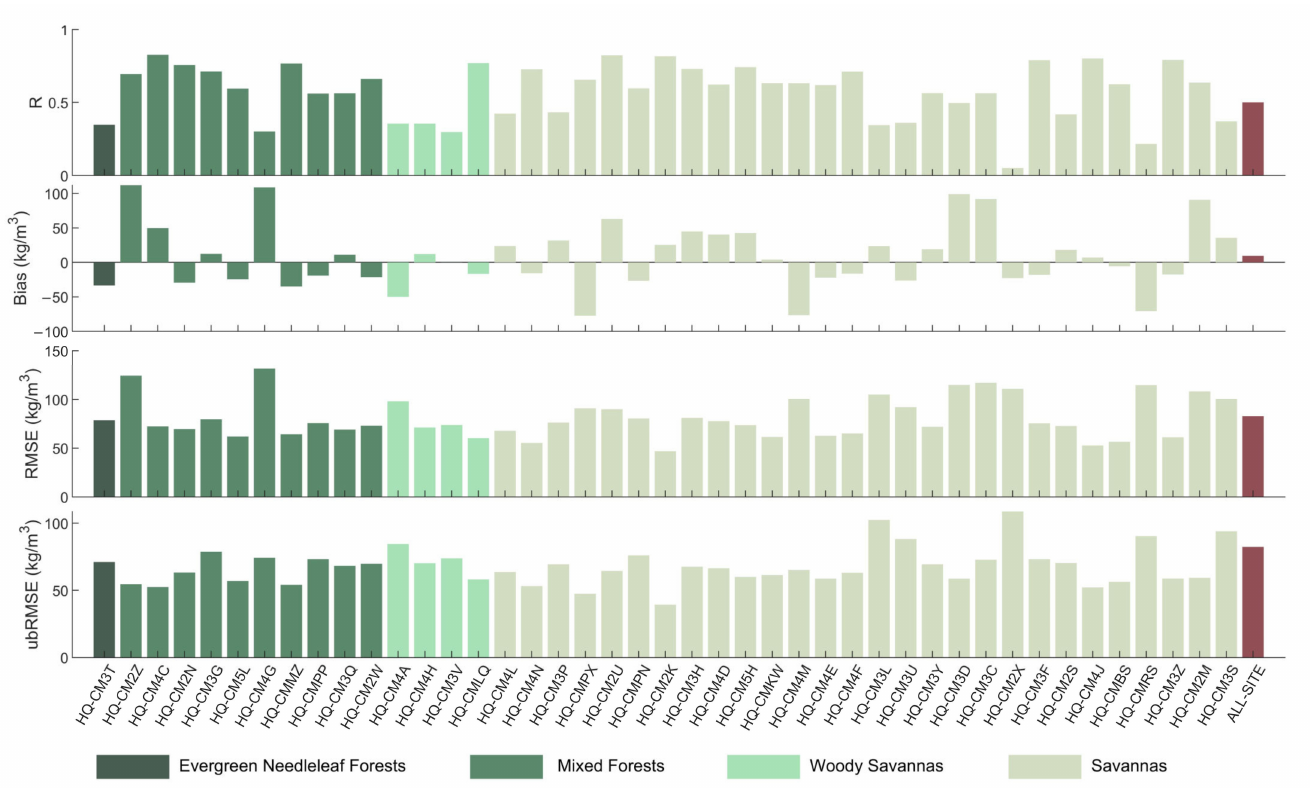
Figure 9. Summary of Pearson correlation coefficient (R), mean bias (Bias), root-mean-squared error (RMSE), and unbiased (ubRMSE) of retrieved snow density at different stations. Different colors represent different dominant IGBP land surface types from